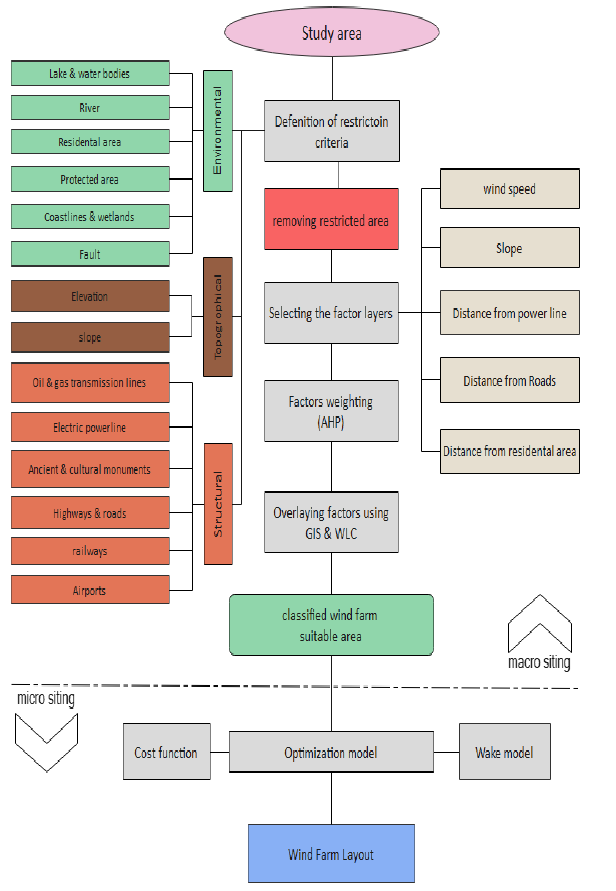
Figure 3 . Exclusion